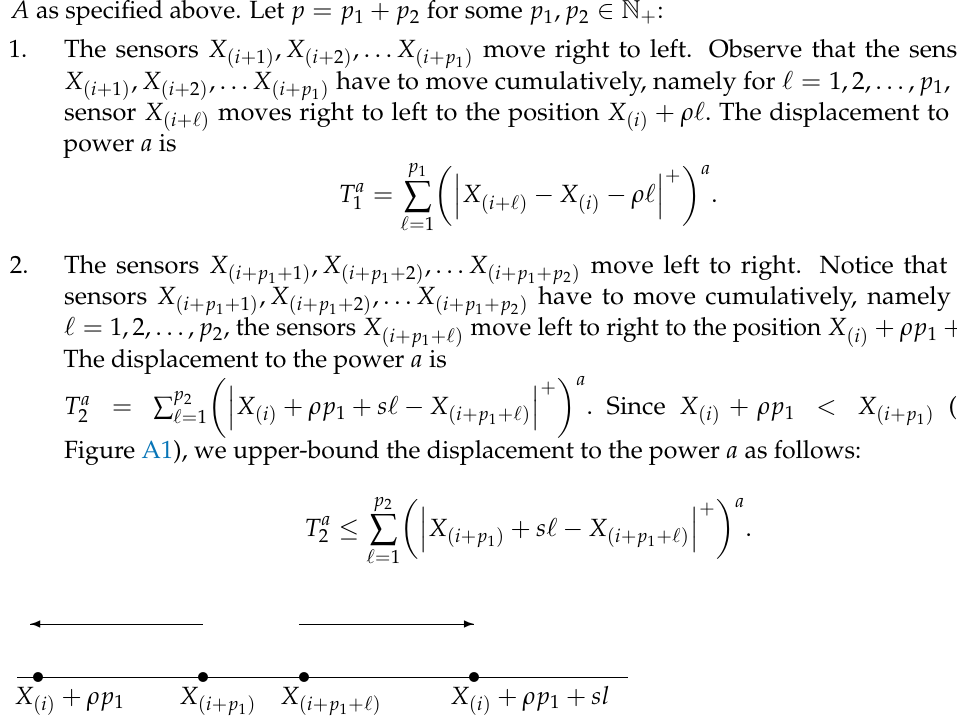
Figure A1. The movement of mobile sensors X ( i + p Algorithm